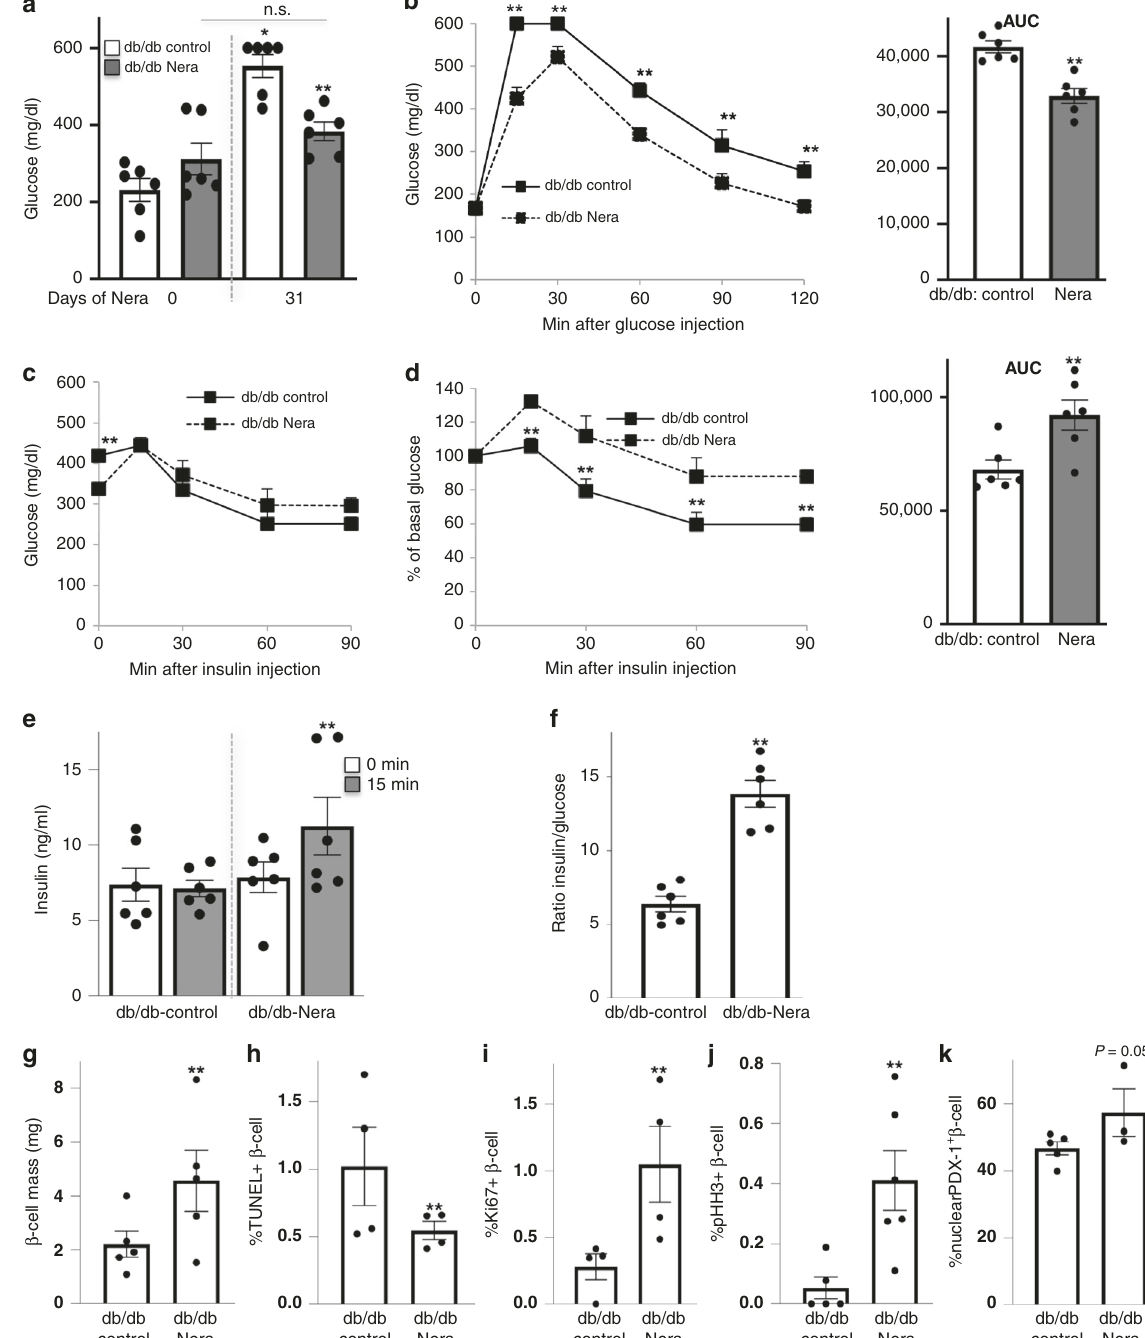
Fig. 8 Neratinib improves glycemia, insulin secretion, and β -cell survival in obese db/db mouse model of type 2 diabetes. Obese diabetic Lepr db/db mice on the C57BLKS/J background (db/db) were randomized in two groups at the age of 6 weeks, and then, neratinib or vehicle was daily i.p. injected at a concentration of 5 mg/kg throughout the whole experiment of 31 days. a Random fed blood glucose measurements before and after 31 days of Neratinib or vehicle injection (last day of the study). b Intraperitoneal glucose tolerance test (ipGTT). c , d Intraperitoneal insulin tolerance test (ipITT). In d , basal glucose values were normalized to 100% (respective area-under-the-curve (AUC) analyses for b and d are shown in the right insets). e Insulin secretion during an ipGTT measured before (0 min) and 15 min after glucose injection. f The ratio of secreted insulin and glucose is calculated at fed state. Data are representative of six mice per group ( n = 6 for ( a – f )). g – j Mice were killed at day 31. g β -cell mass (given as percentage of the whole pancreatic section from ten sections spanning the width of the pancreas; n = 5 mice/group) and quantitative analyses from triple stainings for ( h ) TUNEL, ( i ) Ki67, ( j ) pHH3, and ( k ) nuclear PDX1 expression, insulin, and DAPI expressed as percentage of TUNEL-, Ki67-, pHH3-, or nuclear PDX1-positive β -cells ± SEM. An average number of 13667 ( h ), 5937 ( i ), 7108 ( j ), or 4330 ( k ) β -cells were counted from n = 3 – 5 ( h , i , k ) or n = 5 – 6 ( j ) mice/group. Data show means ± SEM. * p < 0.05 vehicle control at the end (10.5 weeks of age) compared with the start of the study (6 weeks of age), ** p < 0.05 db/db compared with db/db-Nera injected mice; by one-way ANOVA with Bonferroni corrections for ( a ); by Student ’ s t tests for ( b – k ). Source data are provided as a Source Data fi